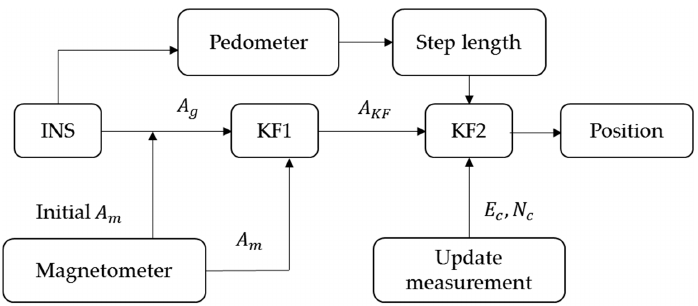
Figure 5. The contrast PDR system used in this study.